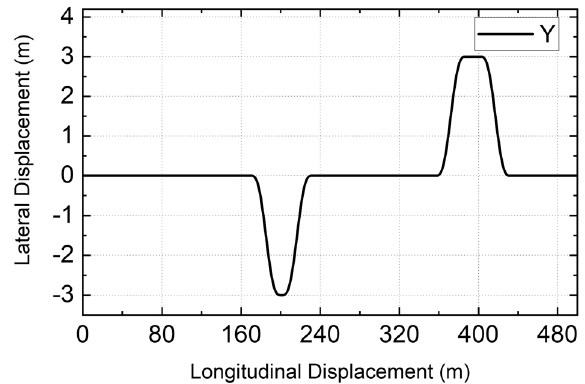
Figure 5. Lateral tracking displacement.